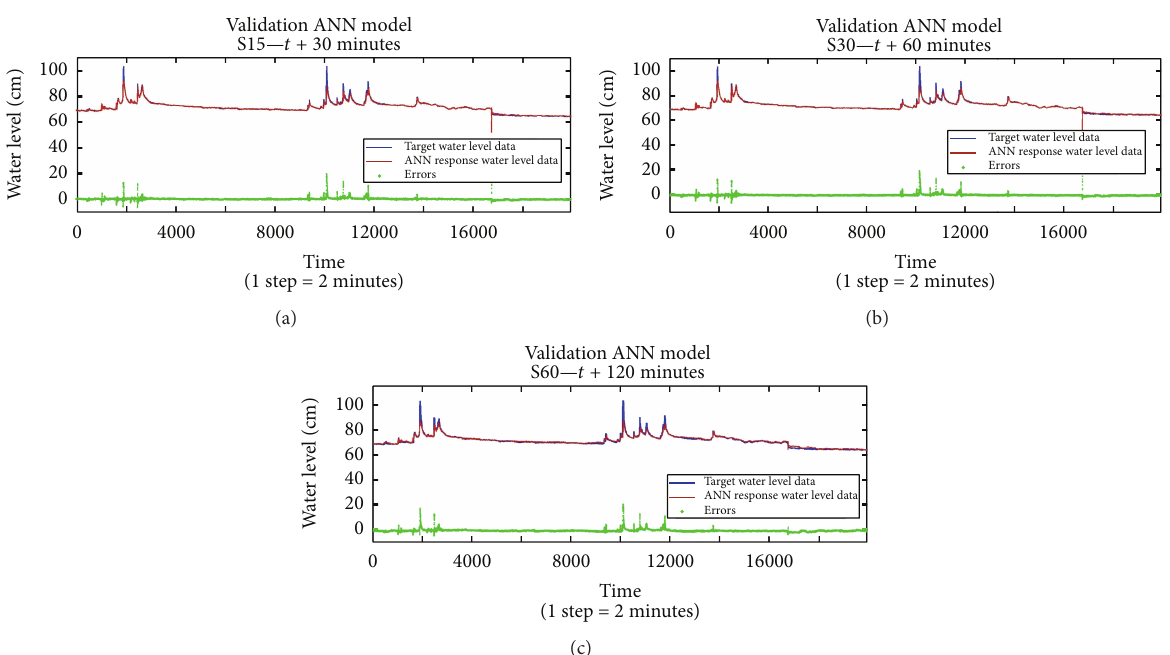
Figure 11: Graphical presentation of the target water level data and response water level data for the ANN model during validation: (a) S15, (b) S30, and (c) S60.